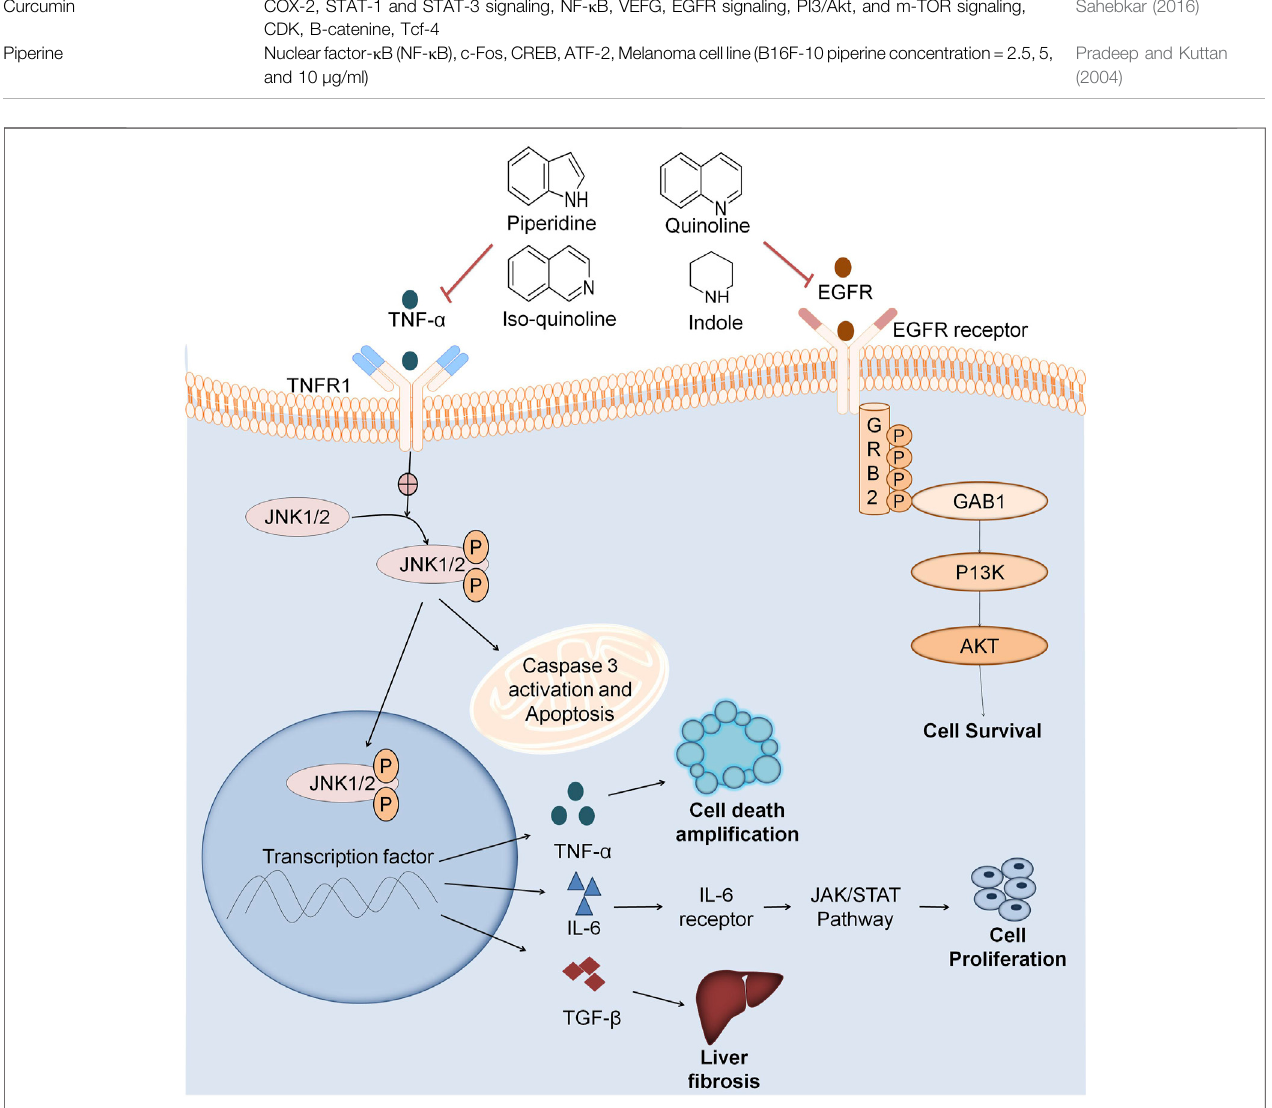
FIGURE 5 | Multitarget based screening of anticancer natural compounds. Pro-in fl ammatory mediators like TNF α , JL2, JL12, etc. binds to the receptor on the cell surface which undergoes a conformationalchange and activates JNK 1/2.JNK1/2 phosphorylationleadsto apoptosis that releases in fl ammatory factors like NFK β that also releases in fl ammatory factors like TNF- α which plays role in cell death ampli fi cation. IL6 activates JAK/STAT pathway that results in cancer cell proliferation. TGFF β also activates various pathways leading to liver fi brosis. EGFR binds to the cell surface receptor that activates GRB2. Phosphorylation of GRB2 activates the downstream pathway as GABI further activates P13K that activates AKT leading to cell survival. Natural fragments like indole, quinoline, isoquinoline, and piperidine inhibit both the in fl ammation pathway and EGFR in cancer cell growth.